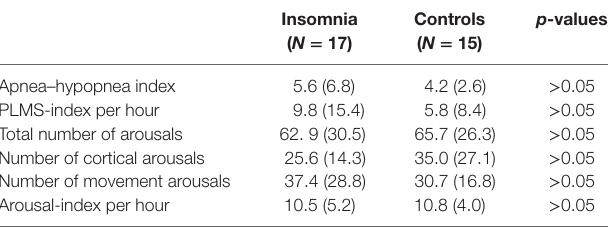
TaBle 3 | Micro structure of sleep parameters.